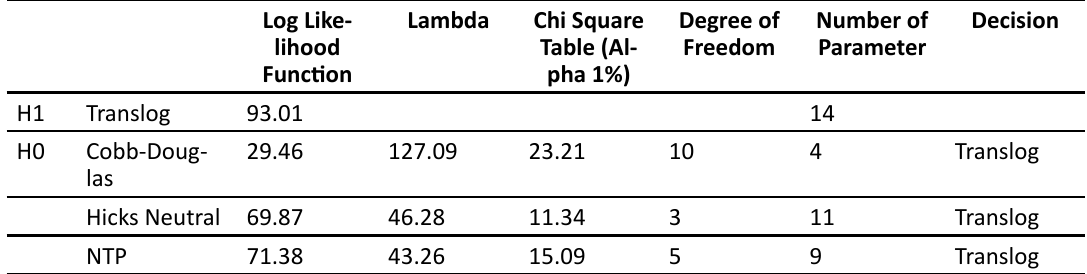
Table 3: Likelihood-Ratio (LR) Test and Maximum Likelihood